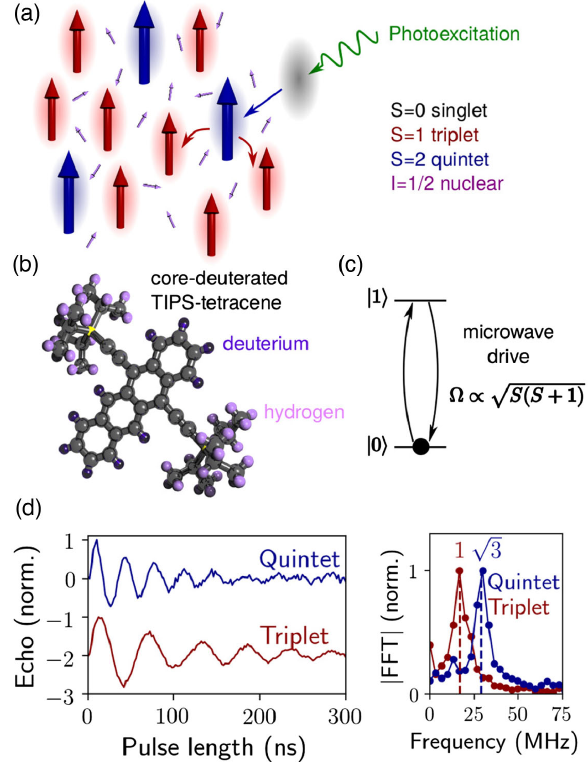
FIG. 1. Coherent spin selection of quintet and triplet states formed by singlet fission. (a) Schematic of coexisting quintet, triplet, singlet, and nuclear spin states in a singlet fission material. (b) Core-deuterated TIPS-tetracene with deuterons on the tetra- cene core (dark purple) and protons on the side groups (light purple) indicated. (c) Basis of coherent spin selection: the micro- wave drive strength Ω (the Rabi frequency) between m ¼ 0 and m ¼ 1 spin states depends on the total spin S , enabling quintet and triplet states to be separately addressed. (d) Rabi oscillations for quintet and triplet states in a core-deuterated TIPS-tetracene film, along with the corresponding fast Fourier transform (FFT) show- ffiffiffi p 3 ing the expected factor of between the nutation